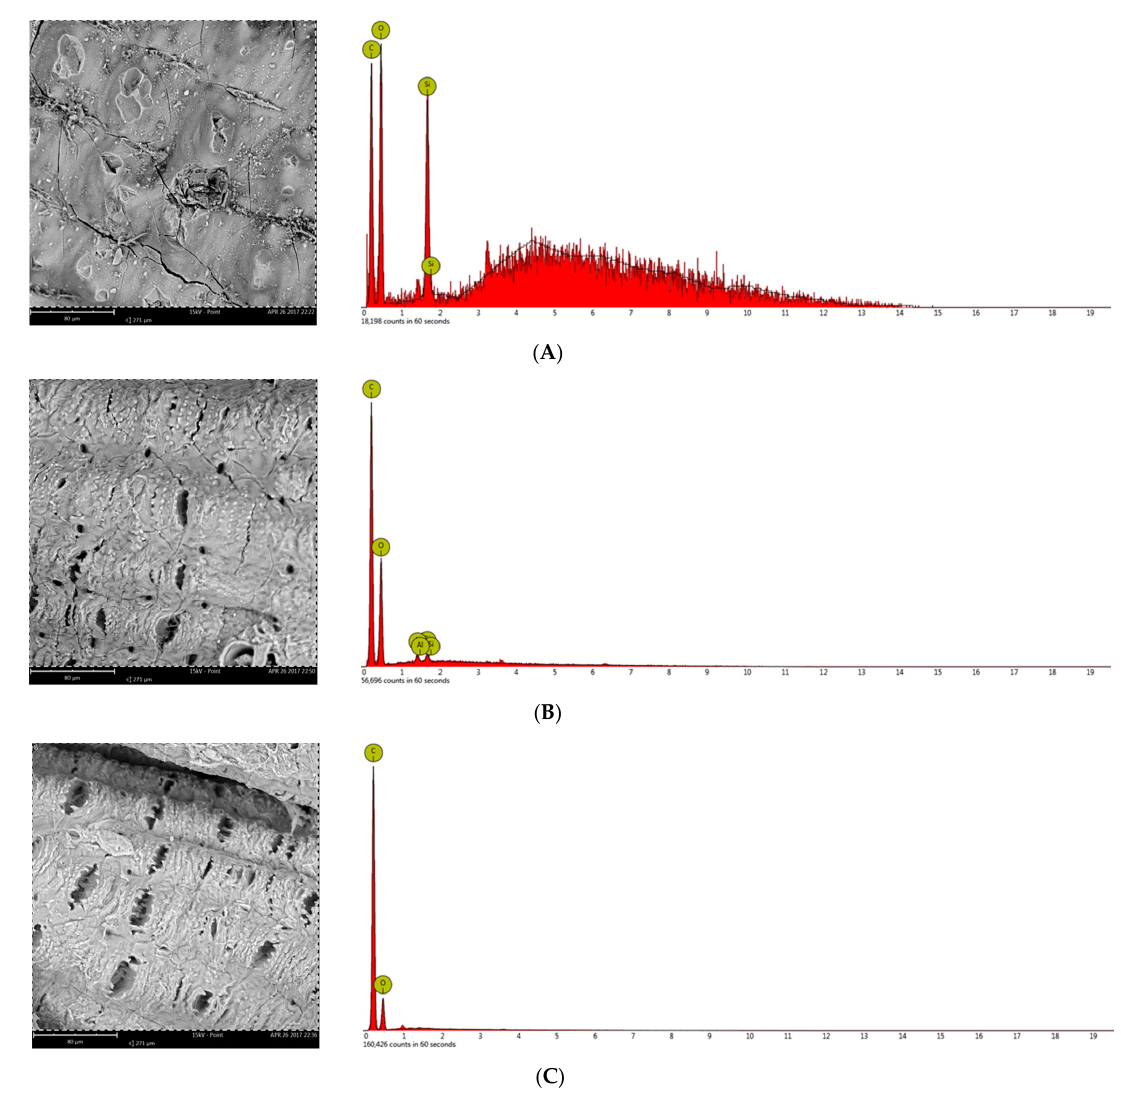
Figure 3. SEM pictures and EDS analysis of rice husk face: ( A ) Unpretreated rice husk; ( B ) after H 2 O 2 pretreatment with 3% ( v / v ) H 2 O 2 at 80 °C for 48 h; and ( C ) after combined H 2 O 2 -aqueous ammonia treatment with 3% ( v / v ) H 2 O 2 at 80 °C for 48 h and 20% ( v / v ) Aqueous ammonia at 100 °C for 5 h. The scale bars are 80 μ m.